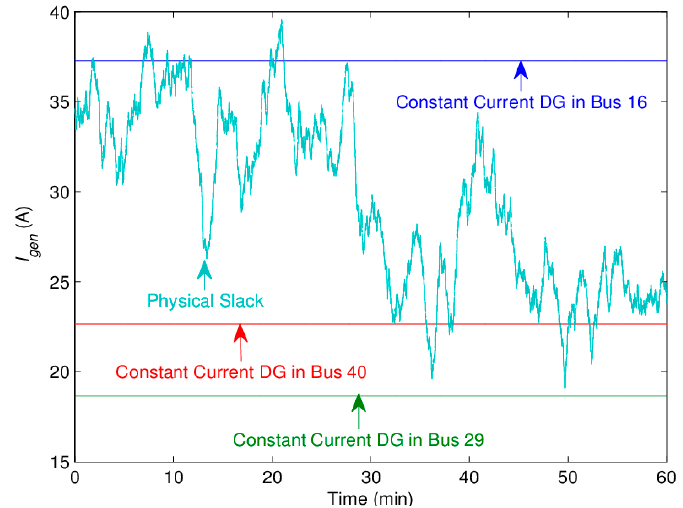
Figure 10. Currents of physical slack and constant current controlled DGs.